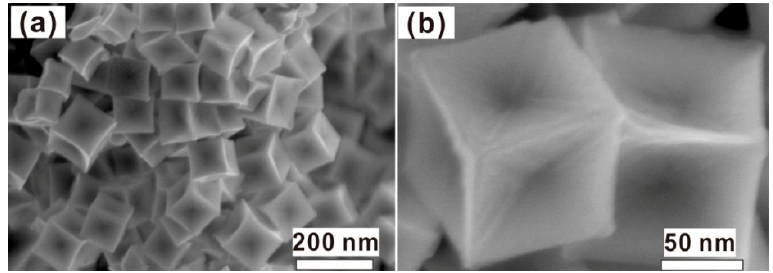
Figure 5. FESEM images of the products obtained by injecting 50 μ L Au seeds into the growth solution at the rate of 10 μ L/min. ( a ) Low and ( b ) high magnification.